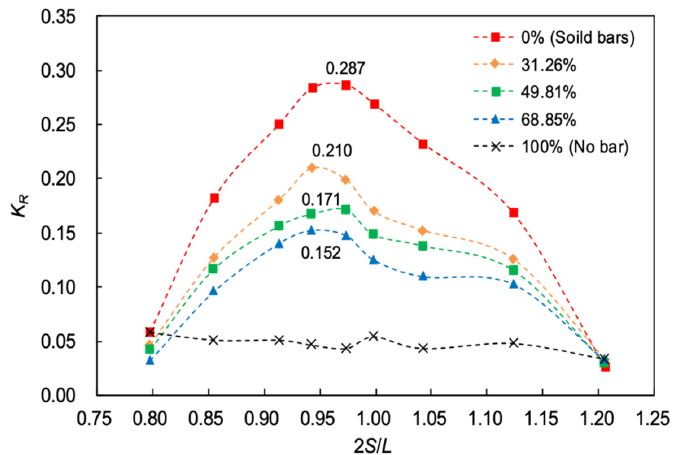
Figure 8. Influence of submerged breakwater permeability φ on Bragg resonant reflection, rectangle, N = 4, B = 0.2 m, S = 1.0 m, h = 0.25 m, and H = 0.04 m.